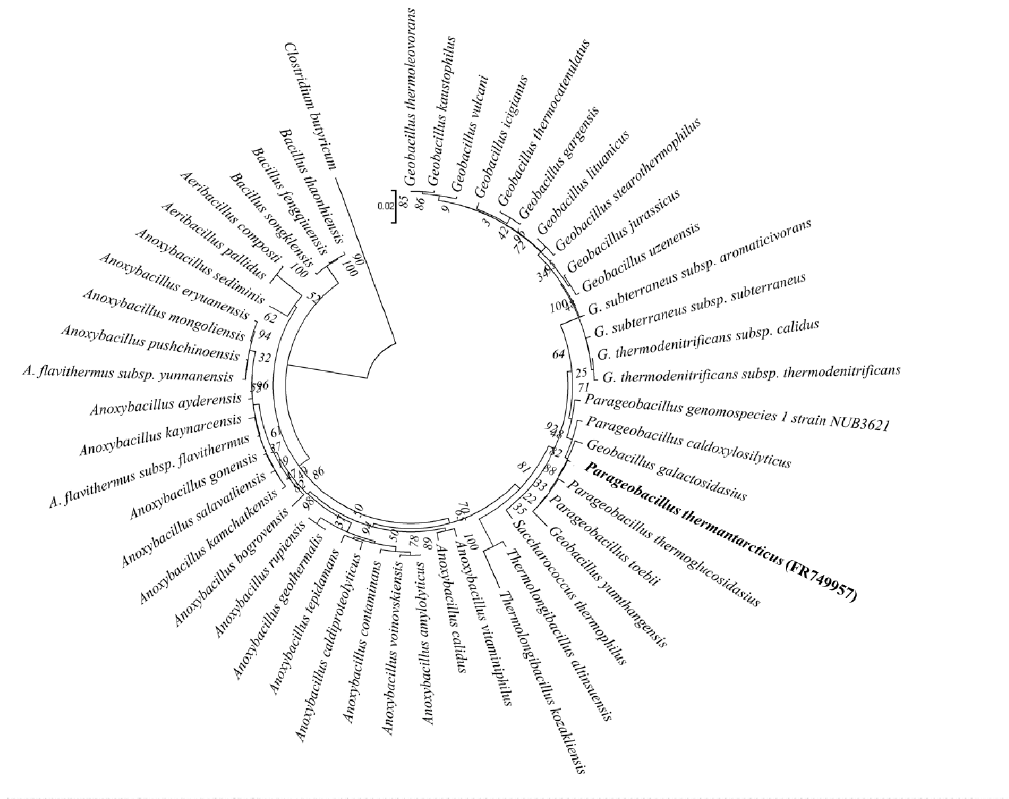
Figure 2. Neighbor-joining phylogenetic tree, constructed using the 16S rRNA gene sequences of type strains, showing the position of P. thermantarcticus and related taxa. Clostridium butyricum was used as an outgroup.